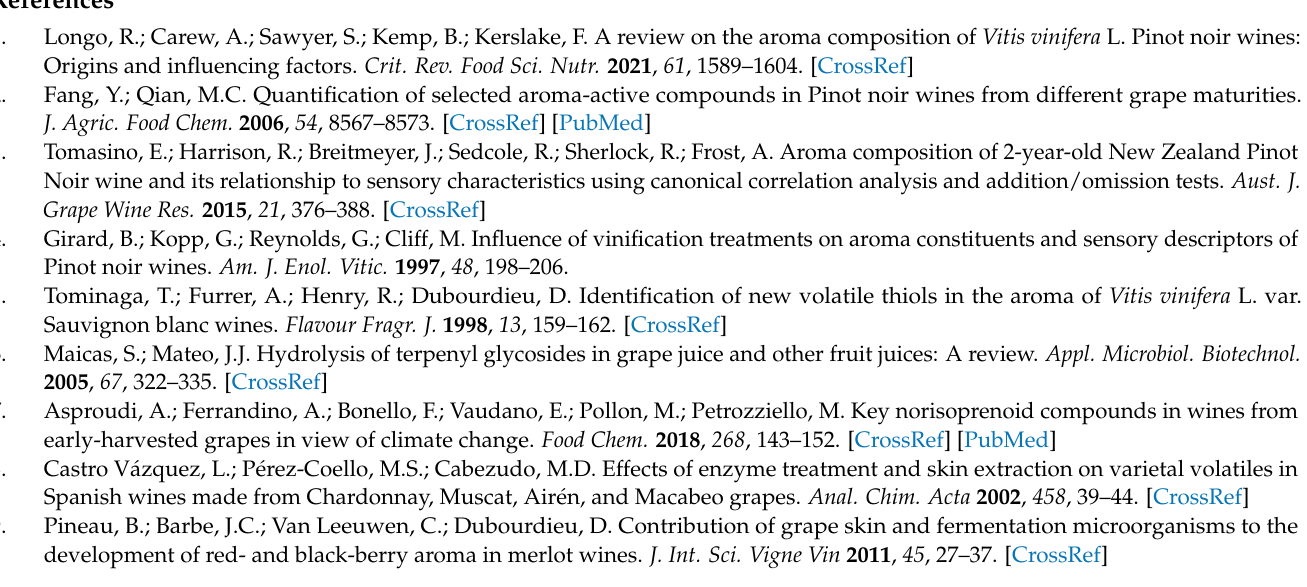
Pinot noir grape juice, Table S2: Ions and retention times (RTs) used to identify aroma compounds and internal standards, Table S3: Species identities of five MSPC isolates (from 96-well positions A3, B3, C3, G2 and H2) selected for Sanger sequencing to represent the three different cohorts identified for MSPC from restriction fragment length polymorphisms (RFLPs) of the ITS1-5.8S rDNA-ITS2 region, Table S4: Microsatellite genotypes of the 19 S. cerevisiae isolates from the MSPC community, Figure S1: title, Cohort determination of the MSPC single vineyard community using the amplification of the ITS1-5.8S rDNA-ITS2 region, followed by RFLP analysis using Hinf I (A) and Hae III (B), Figure S2: Cumulative weight loss (g) over time (h) of fermentations in Pinot noir juice without grape skins (JN), Figure S3: Cumulative weight loss (g) over time (h) of fermentations in Pinot noir juice with grape skins (JS), Figure S4: Cumulative weight loss (g) over time (h) of fermentations in synthetic grape medium (SGM) without grape skins (SN), Figure S5: Cumulative weight loss (g) over time (h) of fermentations in synthetic grape medium (SGM) with grape skins